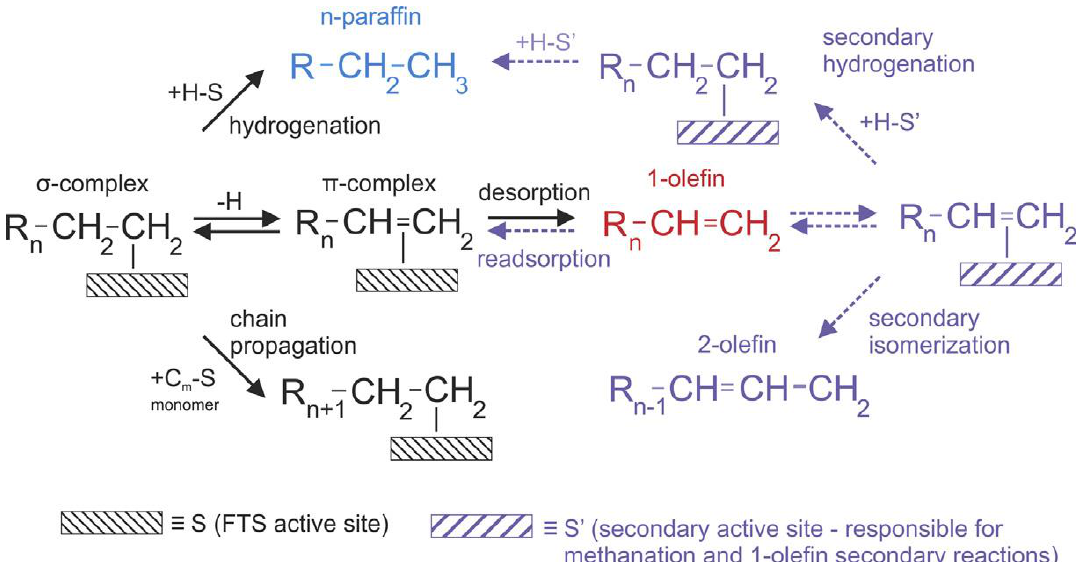
Figure 3. Schematic representation of Fischer–Tropsch synthesis (FTS) (chain propagation, hydrogenation to n-paraffins, and desorption to 1-olefins) and 1-olefin secondary reaction (hydrogenation, isomerization, and readsorption) [87].